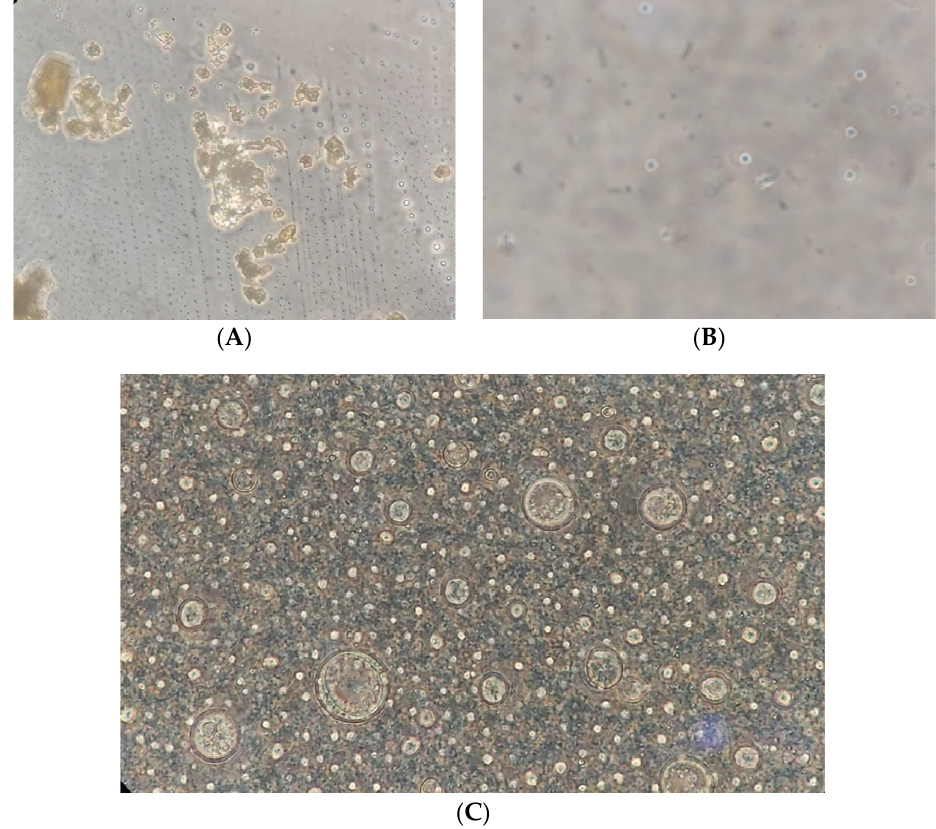
Figure 5. Micrograph of ( A ) purified catechin, ( B ) empty transethosome ( C ) transethosomal catechin in 400× magnification.